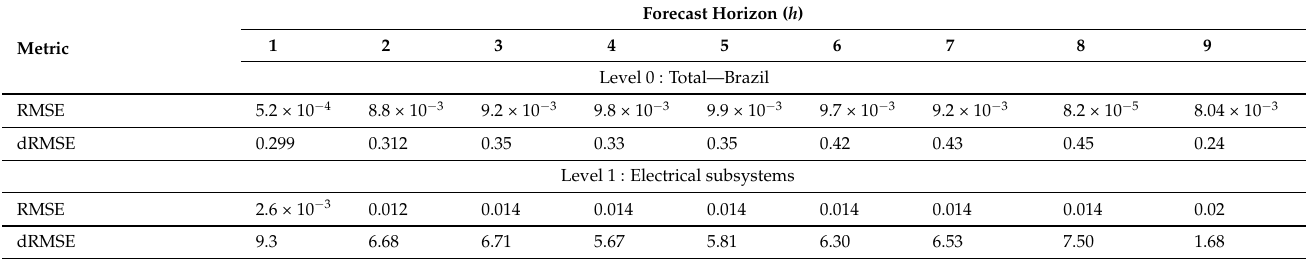
Table 4. Hierarchical forecasting for Brazilian power generation using other performance